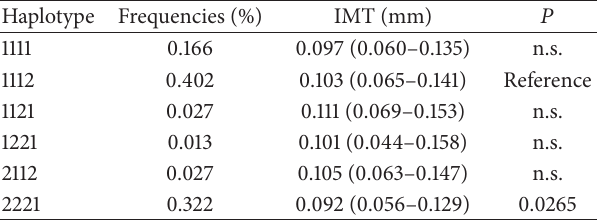
Table3:Haplotypesandintimamediathicknessofcommoncarotid